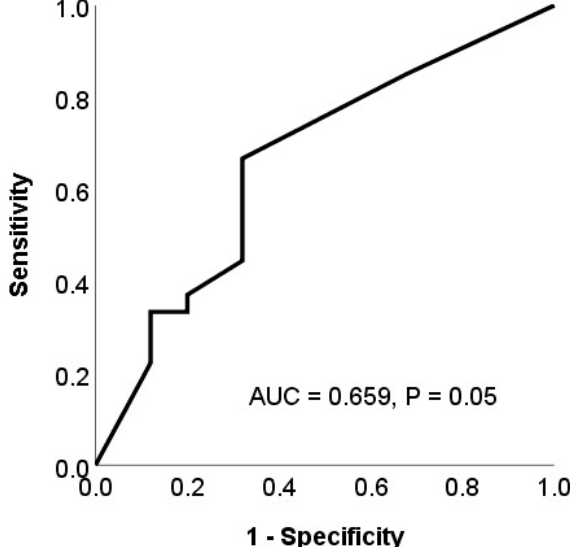
Figure 3. Receiver operating characteristic (ROC) and area under the curve (AUC) analysis of HIP1R expression.